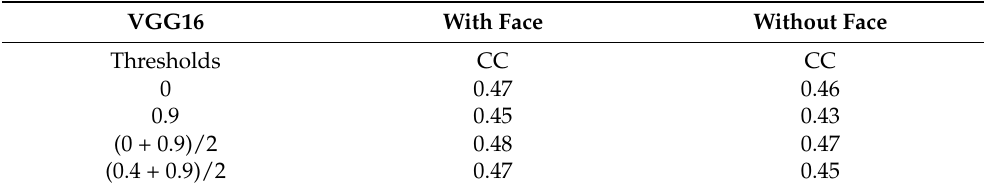
Table 2. The MIT1003 dataset. Tests with different rarity thresholds, both face and without face features on